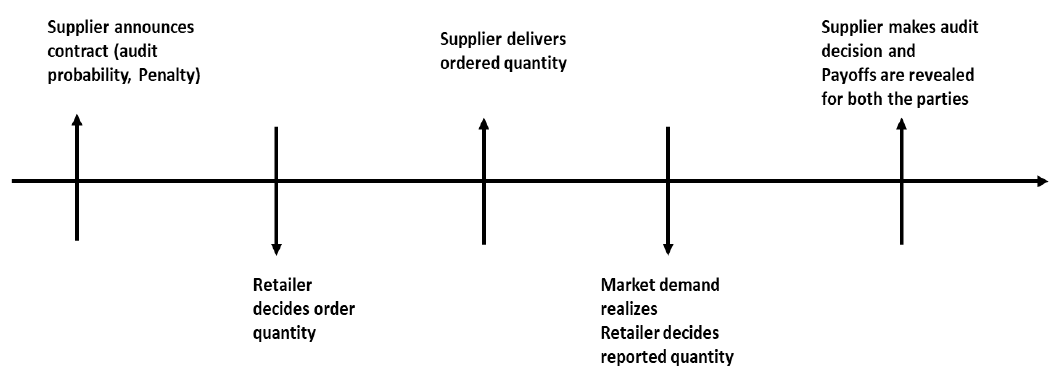
Figure 2. The timeline of